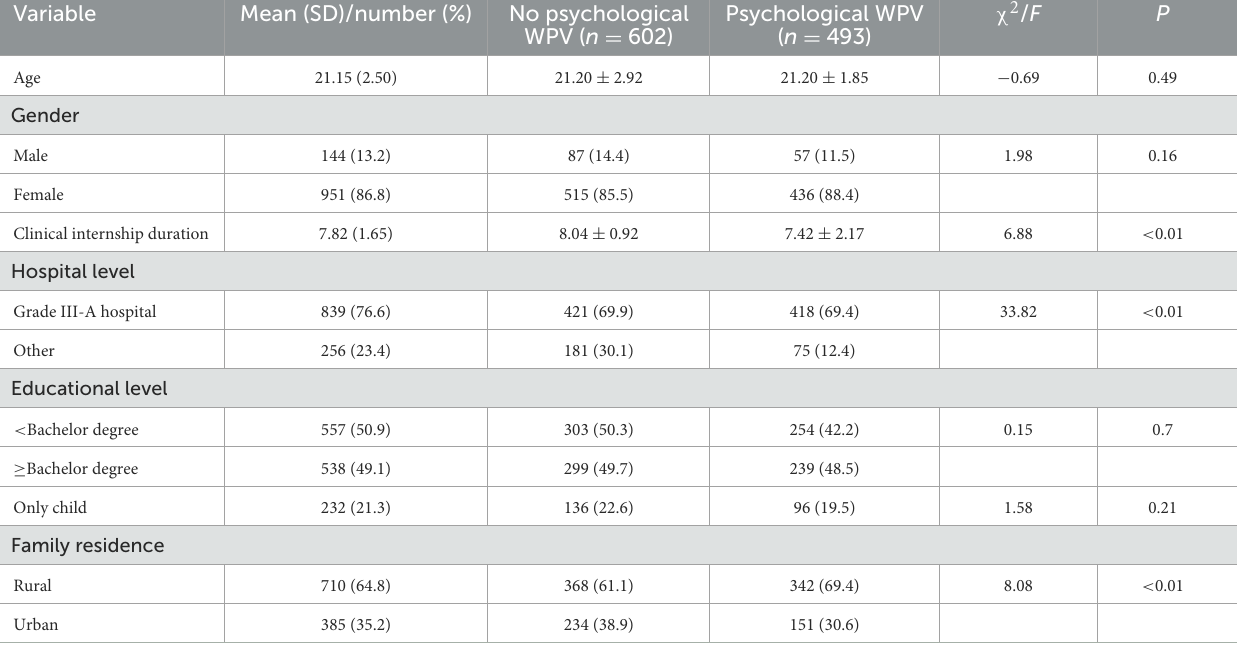
TABLE 1 Demographic characteristics of nursing interns with and without psychological WPV experience ( N = 1,095).